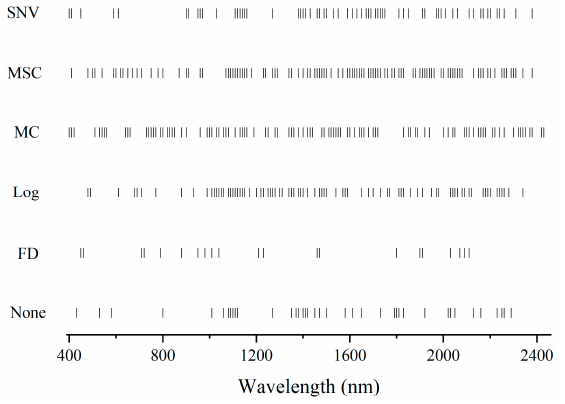
Table 2. Accuracies of soil organic carbon (SOC) estimation using full-spectrum-based partial